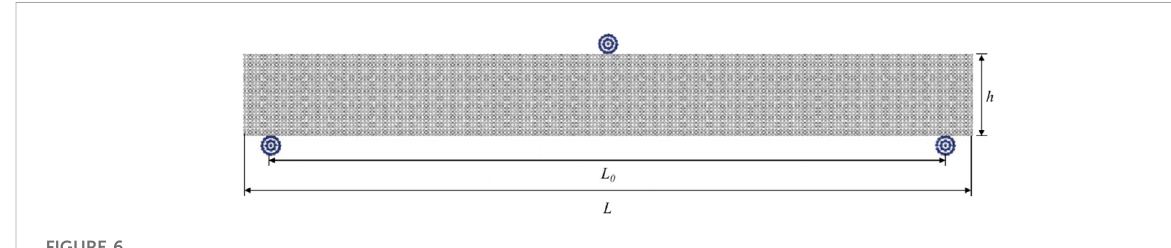
Particle model of three-point bending test of ice